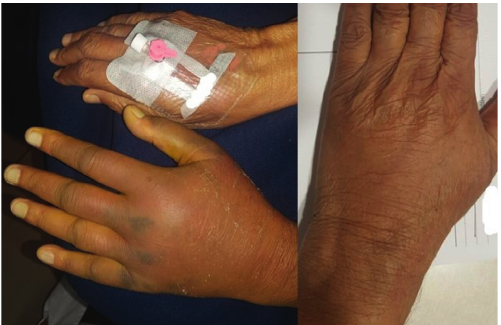
Figure 7: Postprocedure major haematoma in a patient, which resolved after three-week